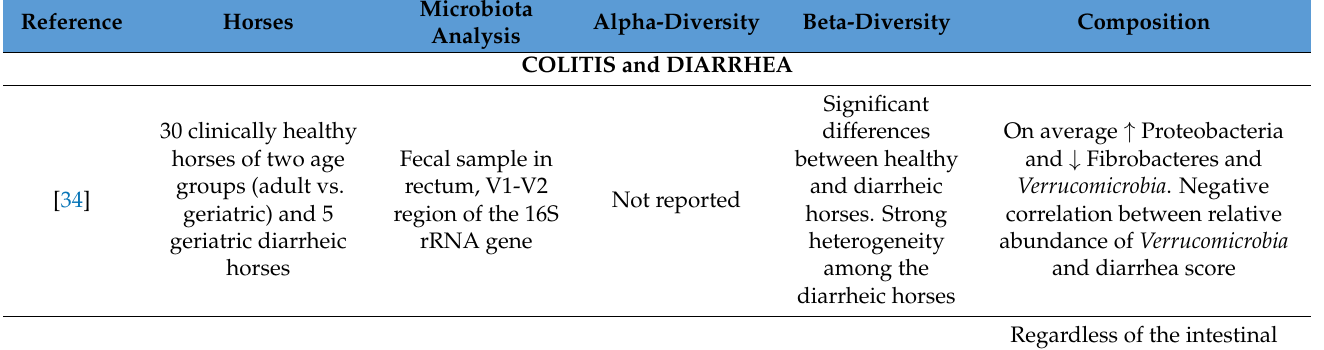
Table 2. Main microbiota changes (alpha and beta diversity, taxonomic composition) measured in the GIT segments of horses according to different hindgut digestive